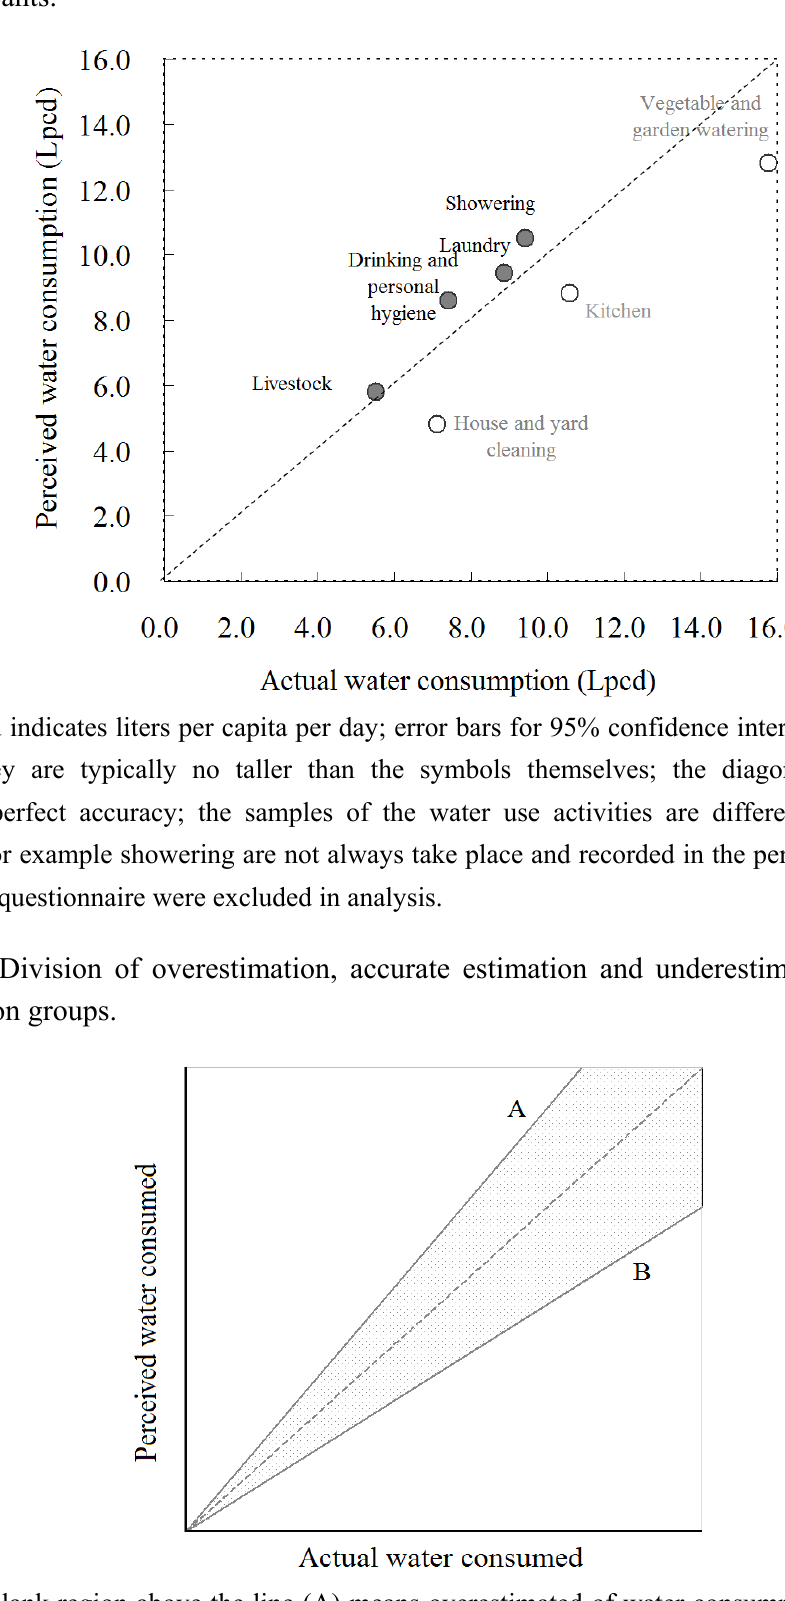
Figure 2. Mean value of perceived and actual water consumed for the water use patterns of the participants.